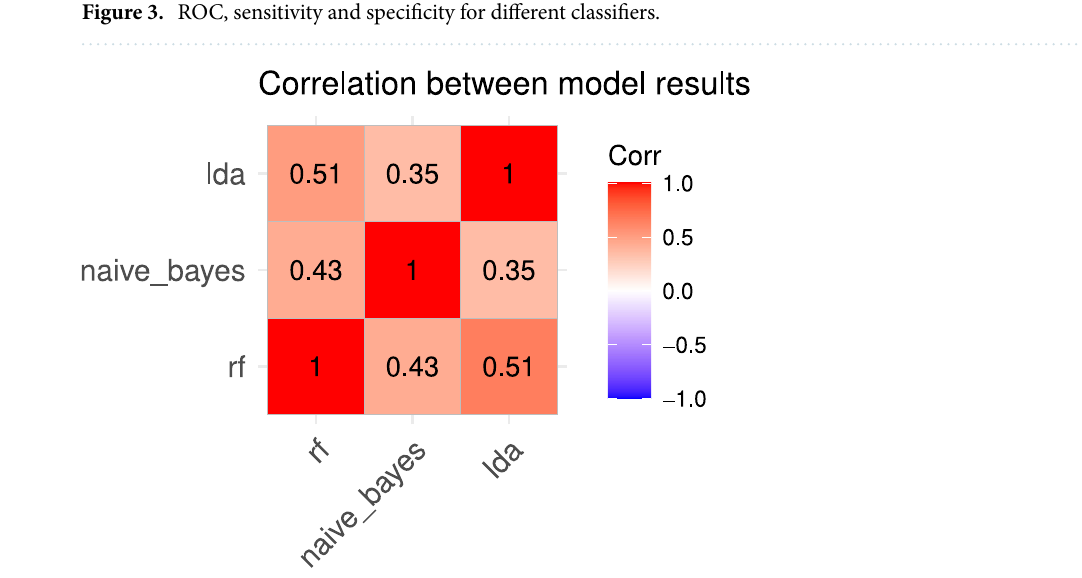
Figure 4. Correlation between the results of base